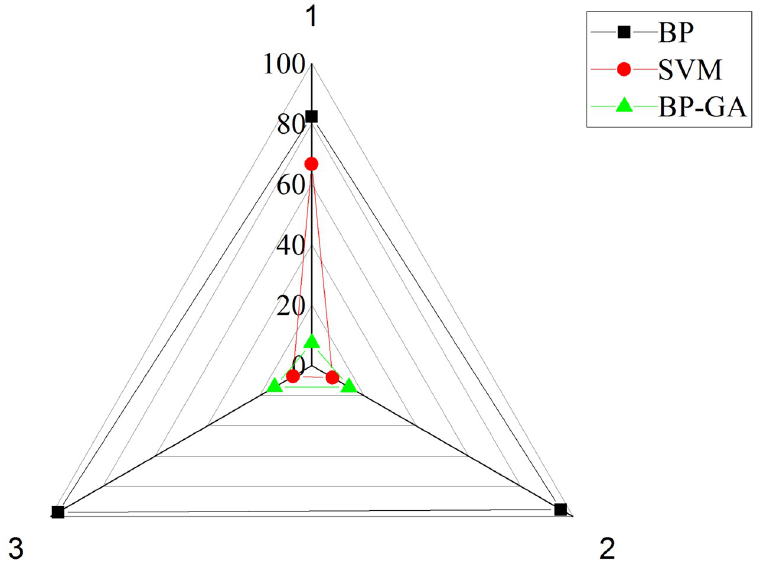
Fig 10. Classification experimental results of SVM, BP model, and BP-GA